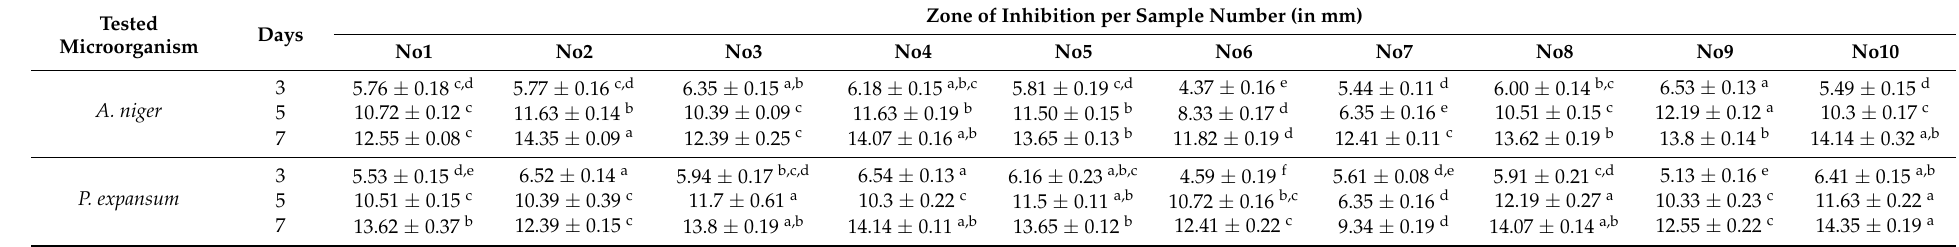
Table 2. Well diffusion assay of fungus, based on the of mycelium growth in mm at 3, 5 and 7 days of extract (samples No1 to No10). Mean values were estimated from four measurements. Tested Microorganism